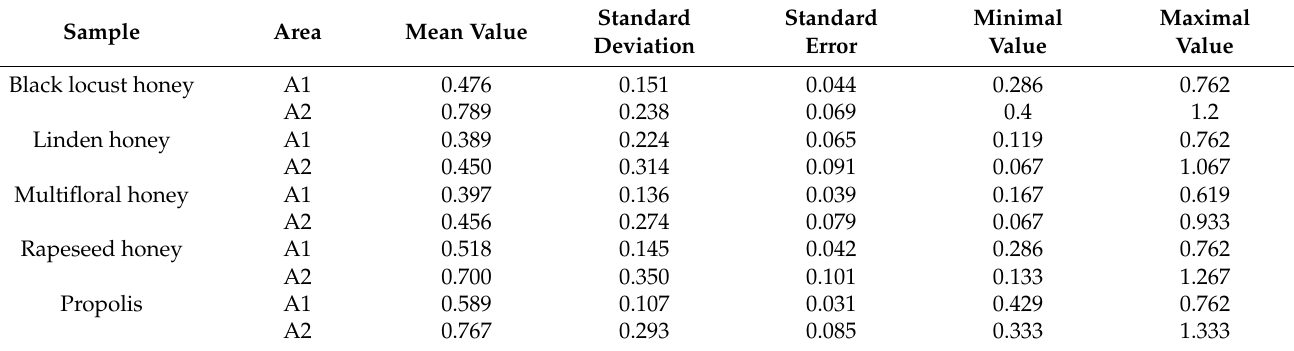
Table 14. Bioconcentration factor for o , p (cid:48) -DDT.